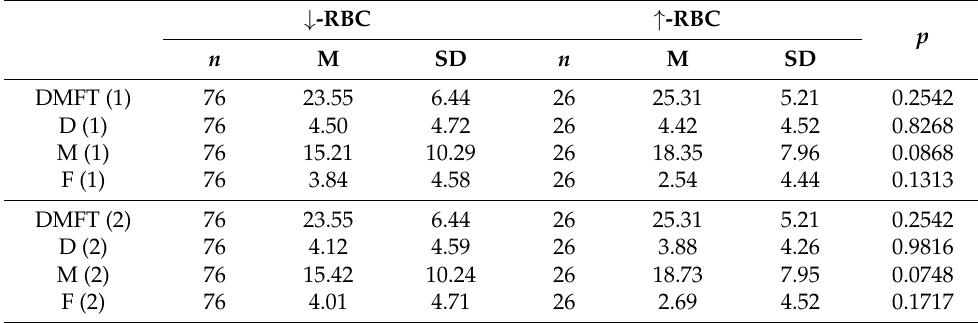
Table 9. Red blood cells count change and DMFT index before (1) and after (2) chemotherapy.